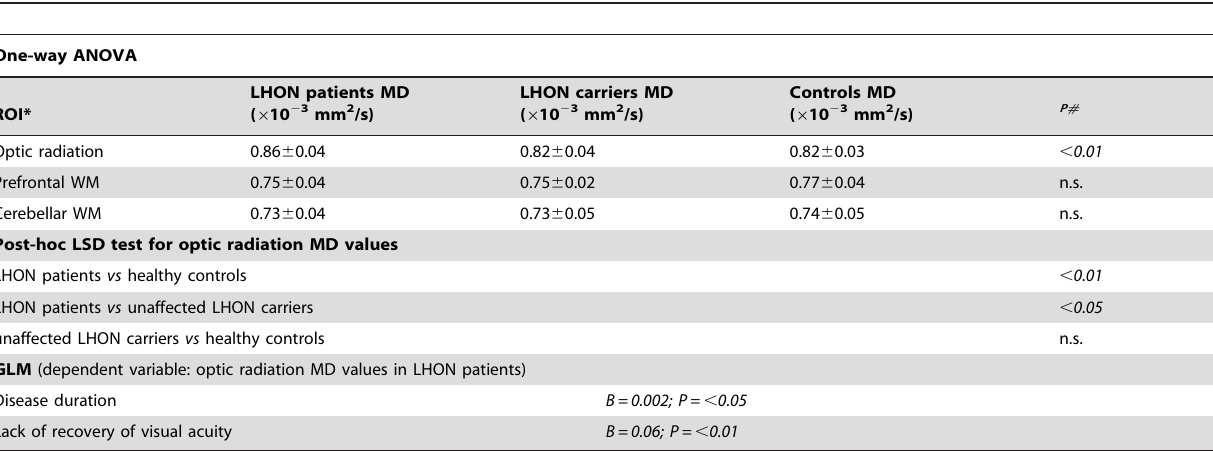
Table 1. MD values of optic radiation, prefrontal white matter and cerebellar white matter in LHON patients, LHON healthy carriers and controls with group comparison results (first two sections).